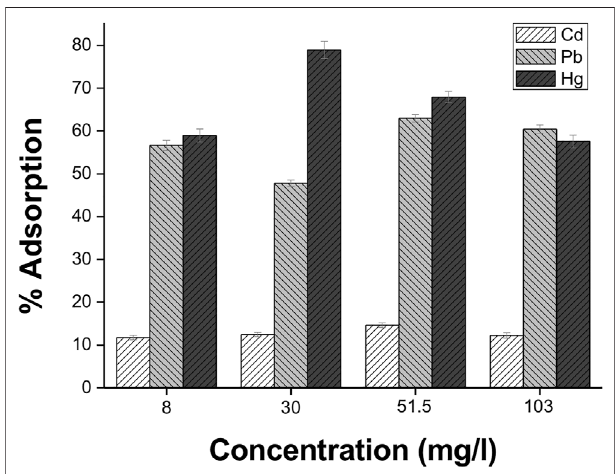
FIGURE 2 | Effect of time of contact in metal adsorption; (A) Pb (II), (B) Cd (II), (C) Hg (II) at (51.5 mg L − 1 ) with Penicillium sp . biomass.